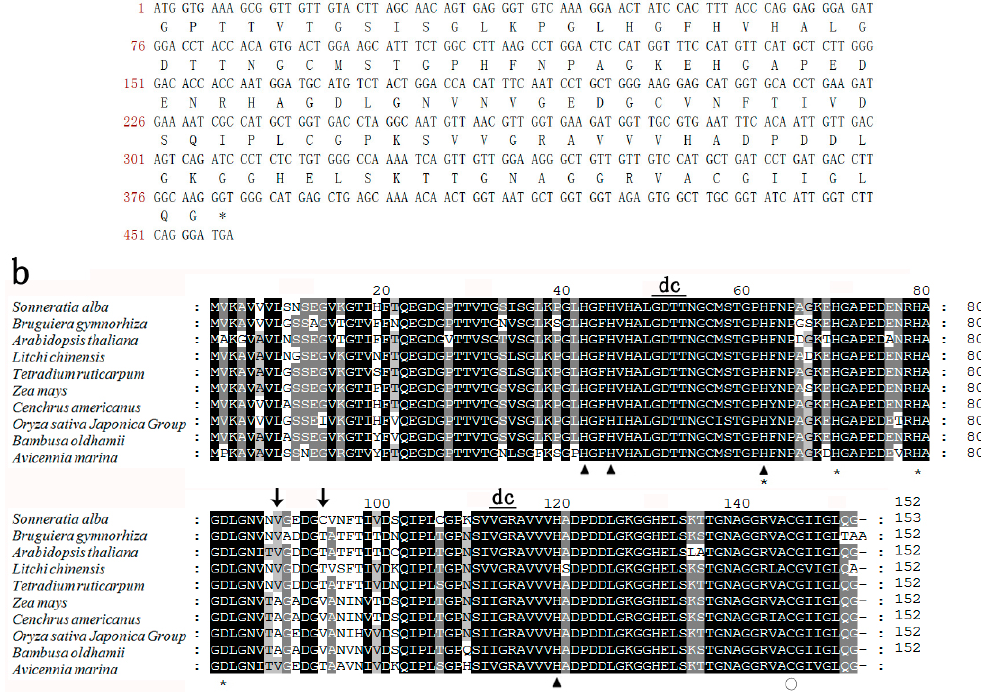
Figure 1. Sequence analysis of SaCSD1. ( a ) Coding sequence and amino acid sequence of SaCSD1; ( b ) Amino acid sequence alignment of CSDs for Sonneratia alba and other species. Triangle denotes copper ion binding sites, asterisk denotes zinc ion binding sites, circle denotes amino acids which form disulphide bonds, arrow indicates changes in the amino acids at the 89th and 94th positions between the plant species belonging to the Poaceae family and other families, and dc represents amino acids involved in dimer contact. Residues that are identical among the sequences are given a black background, and similar residues are in a gray background. The remaining residues are in a white background. Table 1. Amino acid sequence similarity of superoxide dismutases (CSDs) between S. alba and other plant species.